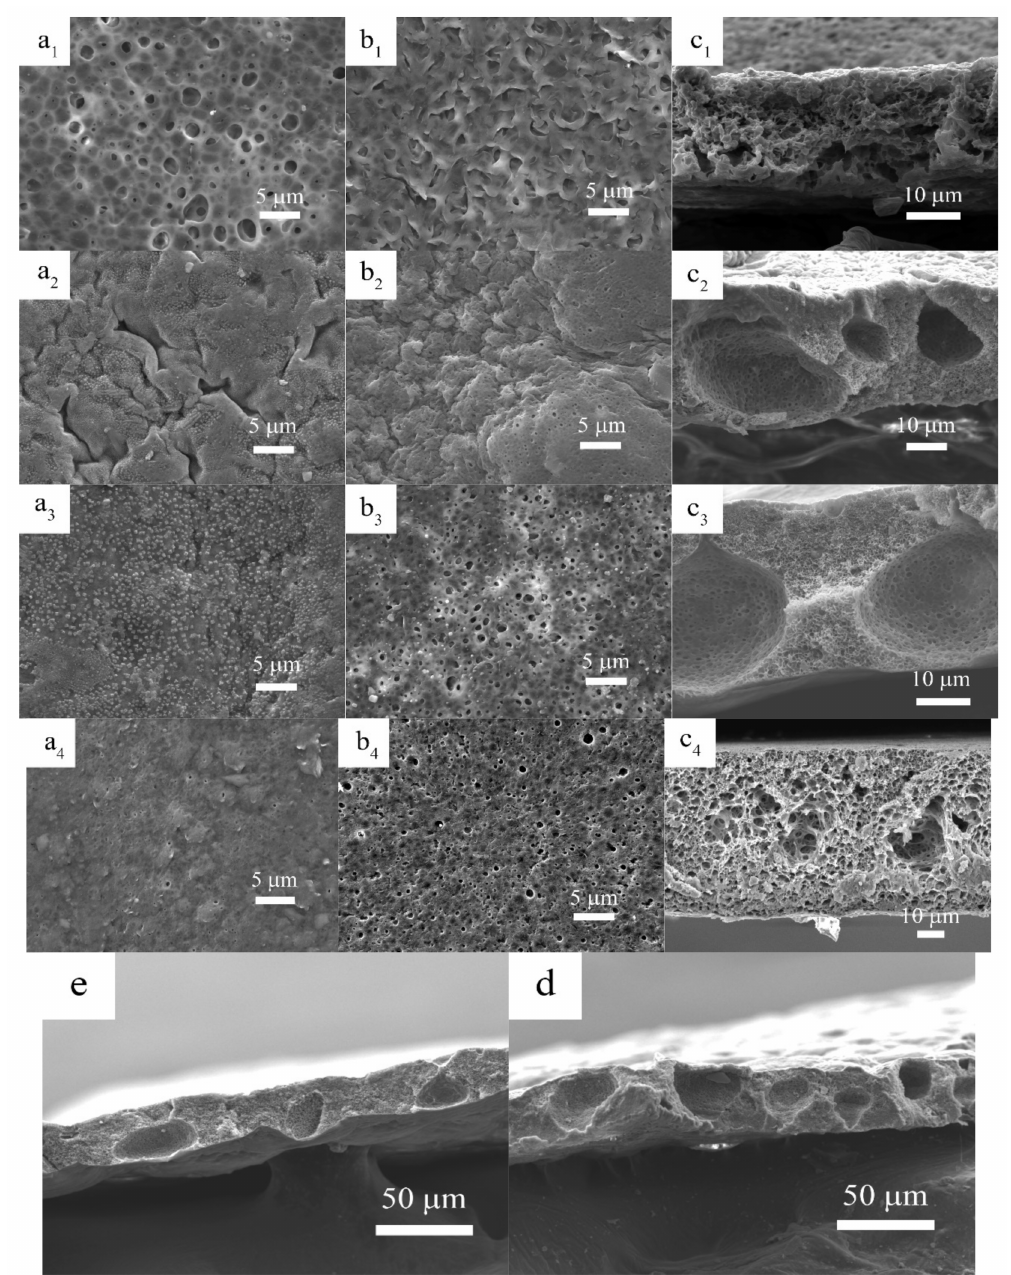
Figure 2. The surface and cross-sectional views of each group of membranes ( a ) shows the view of the upper surface; ( b ) that of the lower surface; and ( c ) shows the cross-sectional view; 1, 2, 3, and 4 are the views when the additional amounts of OVAPOSS were 2%, 5%, 7%, and 0, respectively; ( d , e ) are the cross-sectional views of the membranes with 5% and 7% OVAPOSS added at relatively small